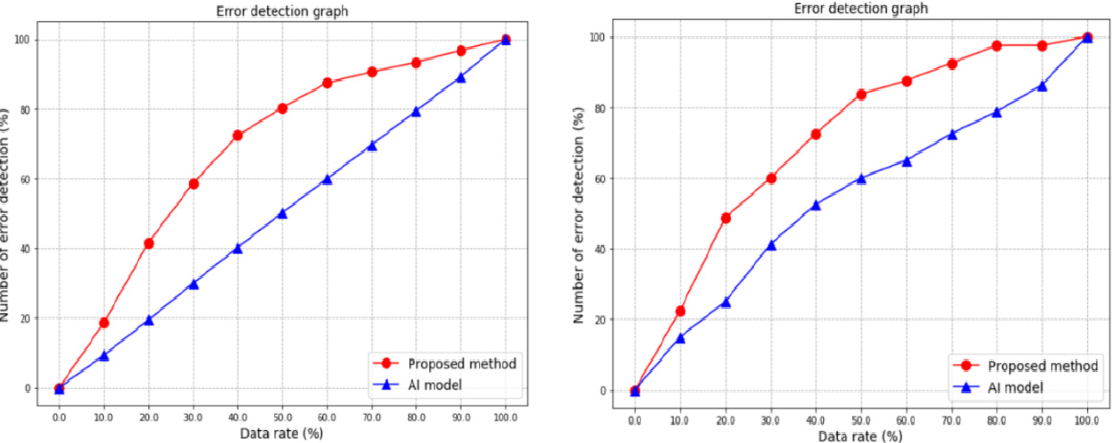
Figure 11. The number of errors detected by the AI model and the proposed method (IDS and malware datasets) [25].